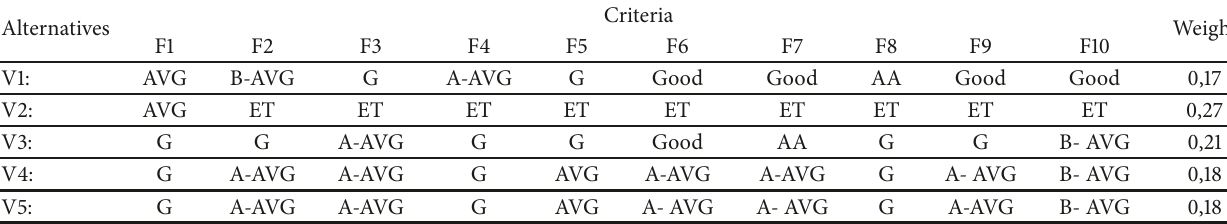
Table 4: Ratings for alternatives.